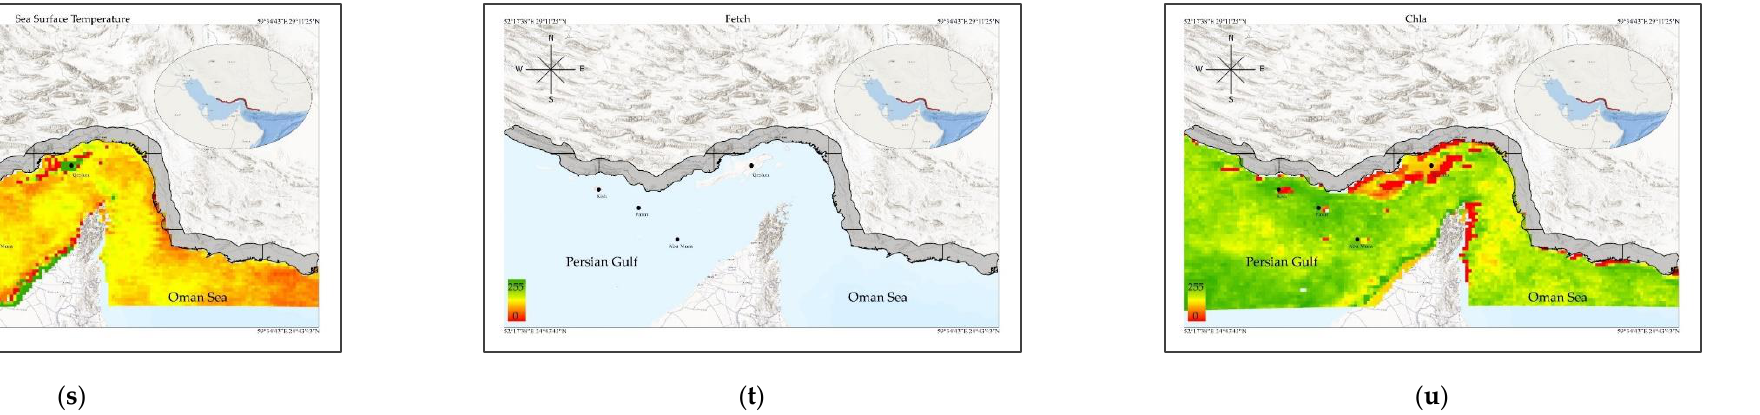
Figure 3. Fuzzy criteria maps: ( a ) building blocks; ( b ) landforms; ( c ) powerlines; ( d ) rivers; ( e ) roads; ( f ) slope; ( g ) protected areas; ( h ) estuary; ( i ) faults; ( j ) floodways; ( k ) city; ( l ) villages; ( m ) coastline; ( n ) geology; ( o ) slope bath; ( p ) depth; ( q ) velocity; ( r ) sea salinity; ( s ) sea surface temperature; ( t ) fetch; ( u ) chlorophyll-a.